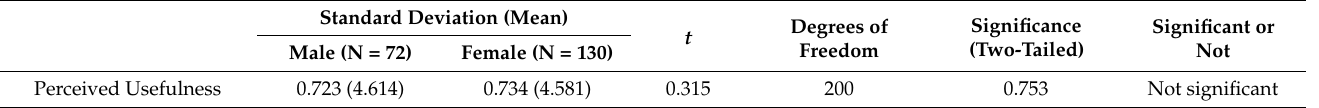
Table 8. T -test of the external variable of perceived usefulness.